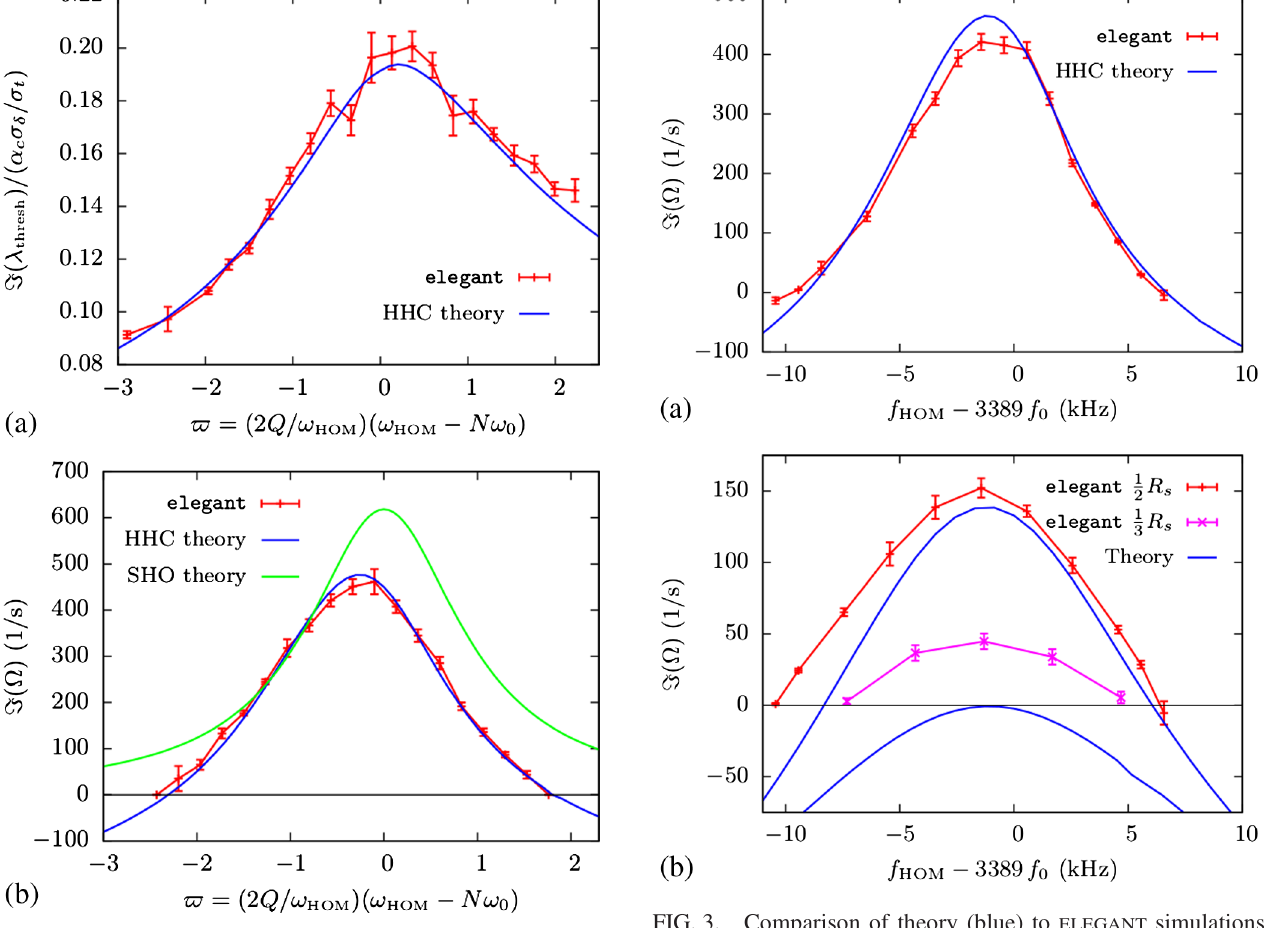
length σ t ≈ 51 ps which was used to compute the matrix